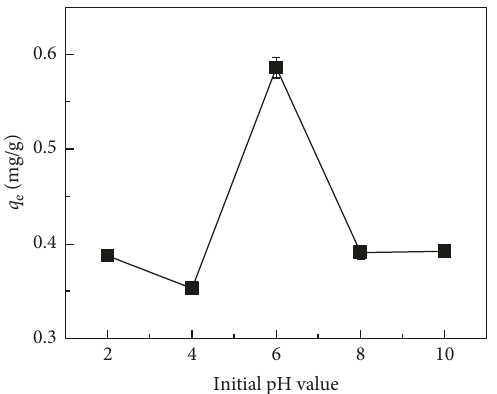
Figure 4: Influence of initial pH on adsorption capacity.